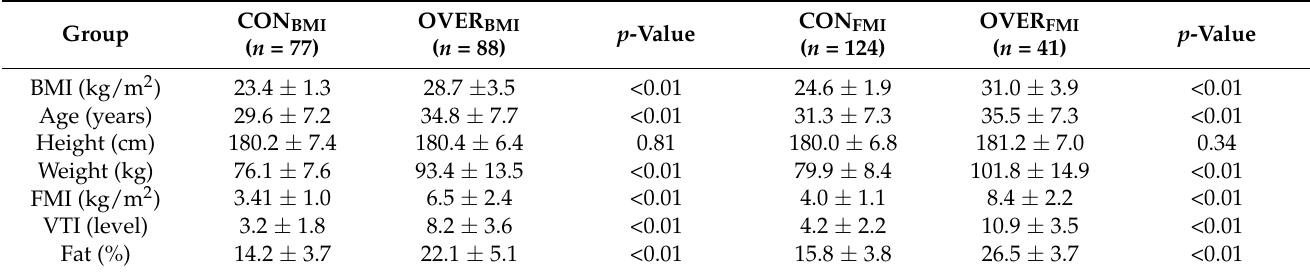
Table 2. Anthropometry and body composition of the